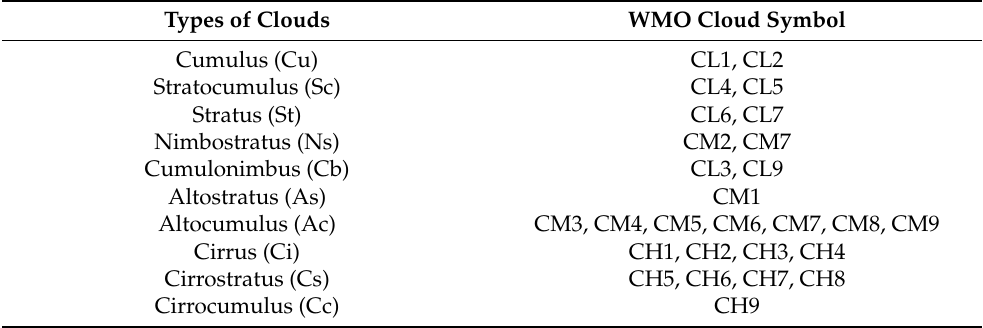
Table 1. Clouds according to SYNOP report. Level of clouds: CL—low, CM—medium, CH—high.